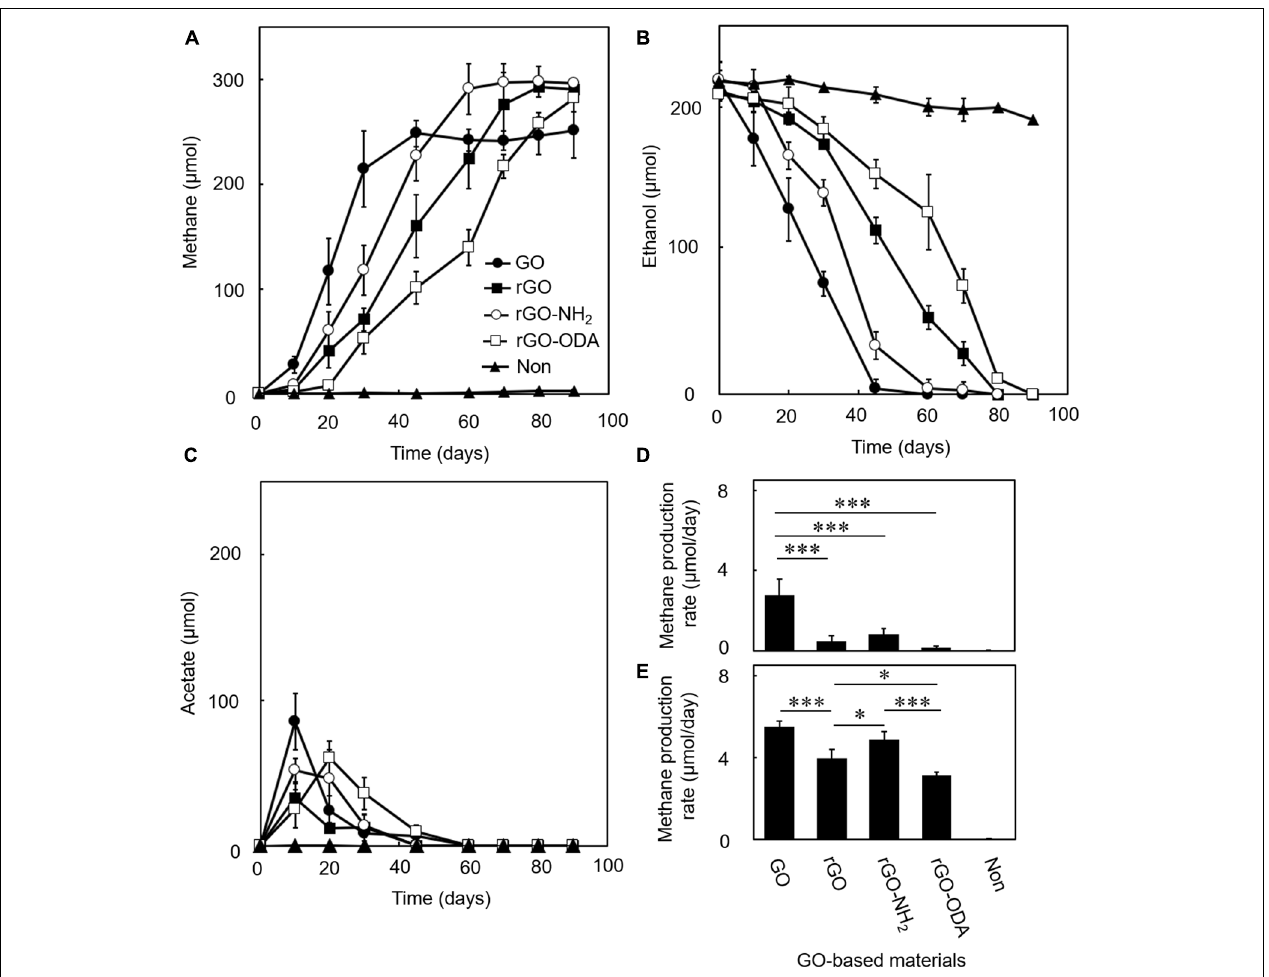
FIGURE 3 | Difference in DIET-promoting efficiencies for GO-based materials. DIET cocultures of Geobacter metallireducens and Methanosarcina barkeri were conducted in the presence of each GO-based material using ethanol as the substrate. Methane (A) , ethanol (B) , and acetate (C) amounts were measured periodically during cultivations. Methane production rates in early- (D) and mid-exponential (E) phases were calculated from the data in (A) . Data are presented as the means of three independent cultures, and error bars represent standard deviations. ∗∗∗ p < 0.001, ∗ p < 0.05 using one-way analysis of variance with Tukey’s honest significance difference